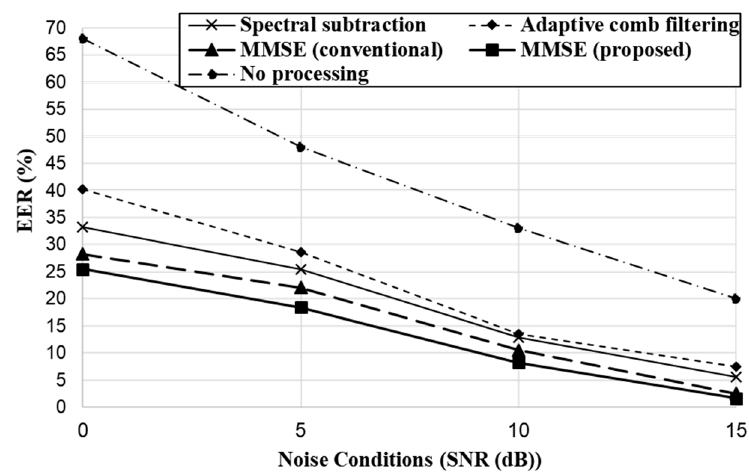
Figure 12. Trigger word detection performance with noisy speech.